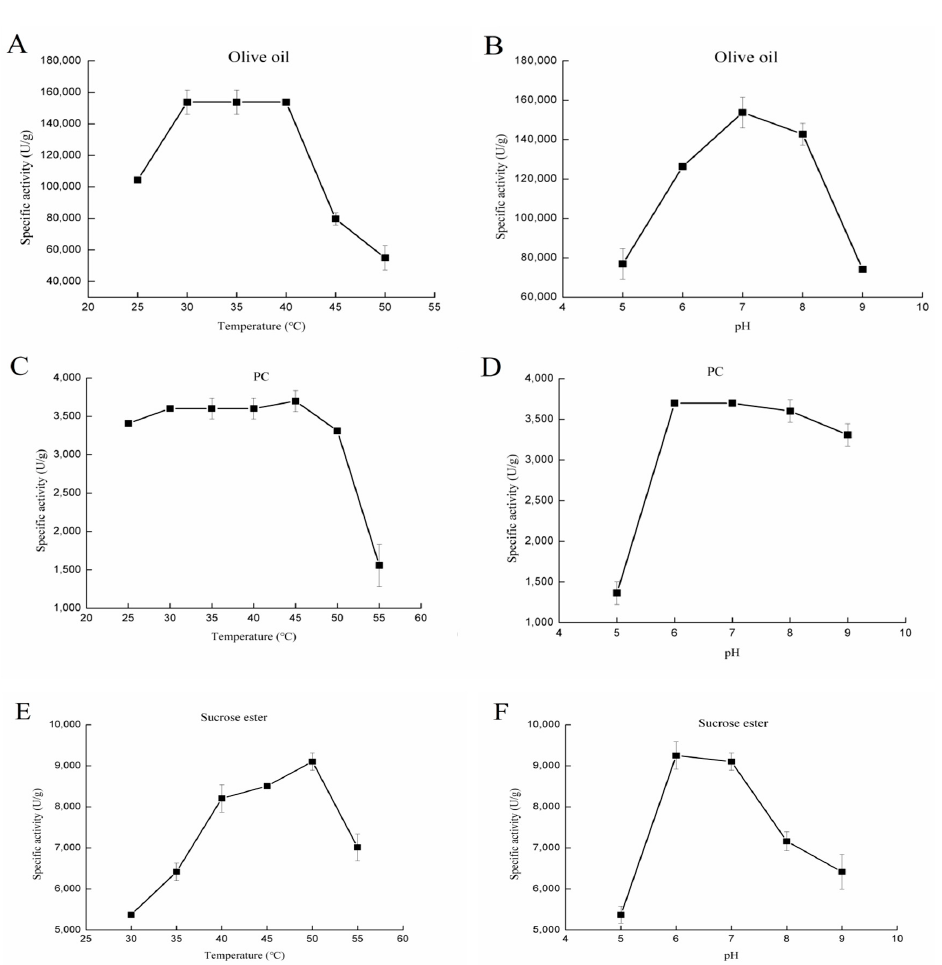
Figure 2. Effect of temperature and pH on specific activity of rGZEL. The purified rGZEL was assayed under different temperatures (25–55 °C) or different pH values (5.0–9.0) by the pH-stat method. Buffers used in this study included 50 mM citric acid-sodium citrate (pH 4.0 and 5.0), 50 mM phosphate buffer (pH 6.0, 7.0), 50 mM Tris-HCl (pH 8.0), and 50 mM Gly-NaOH (pH 9.0). Effect of temperature ( A ) and pH ( B ) on the lipase activity of rGZEL, with emulsified olive oil as substrate. Effect of temperature ( C ) and pH ( D ) on phospholipase activity of rGZEL, with emulsified phosphatidylcholine (PC) from soybean as substrate. Effect of temperature ( E ) and pH ( F ) on glycolipid hydrolysis activity of rGZEL, with emulsified sucrose esters as substrate. Values are Means ± S.D. from three independent experiments.